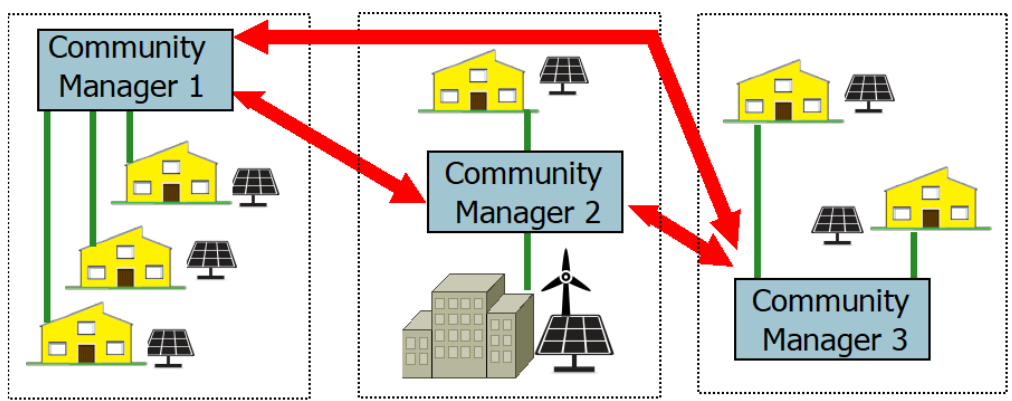
Fig. 3 . Community manager (CM) model